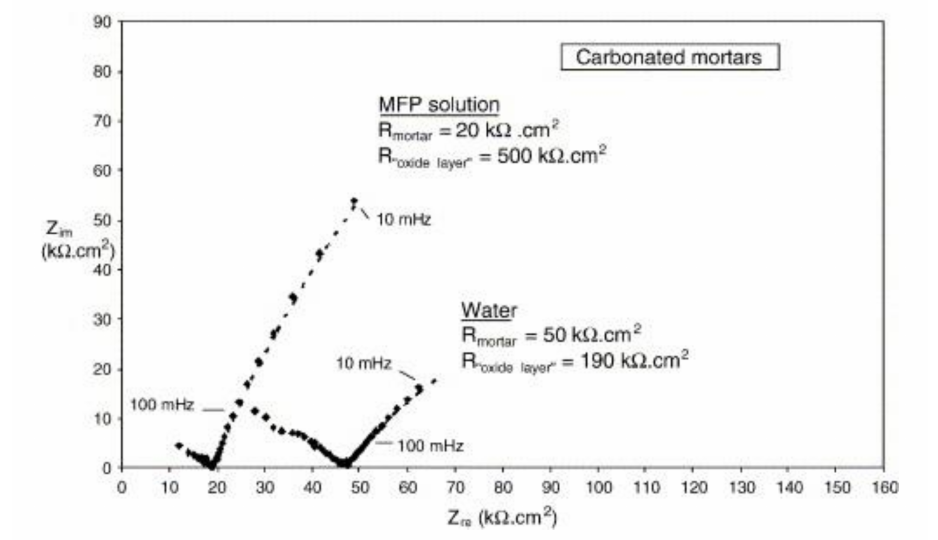
Figure 5. EIS diagrams for carbonated mortars at 48 h after application of aqueous solutions (MFP or water) [61]. Reproduced with permission from Chaussadent, T. et al., Cem. Conc. Res.; published by Elsevier,